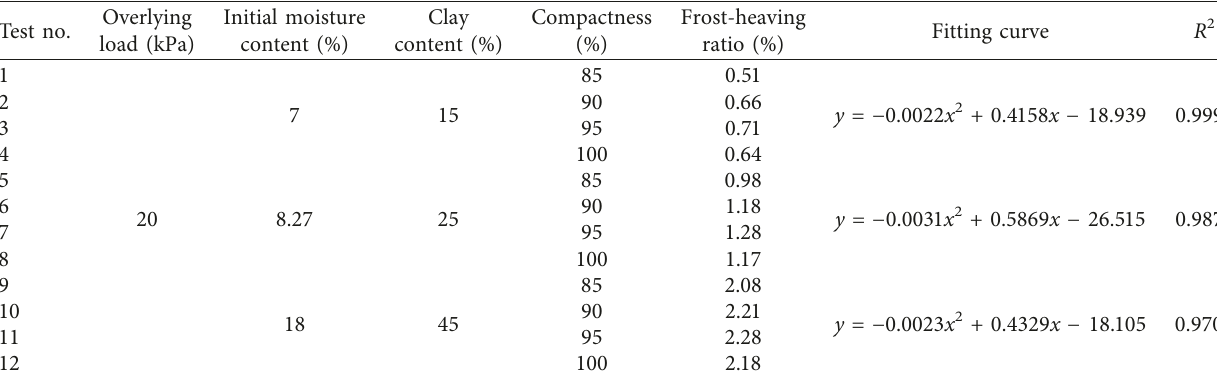
Table 4: Influence of various compactness on frost-heaving